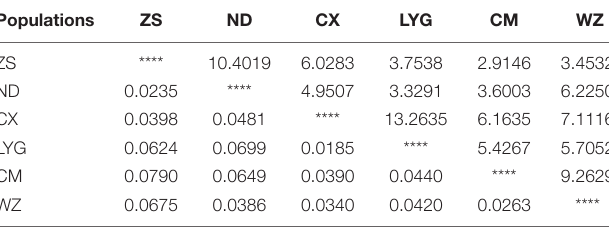
TABLE 6 | Genetic similarity coefficient and gene flow between six populations of rainbow